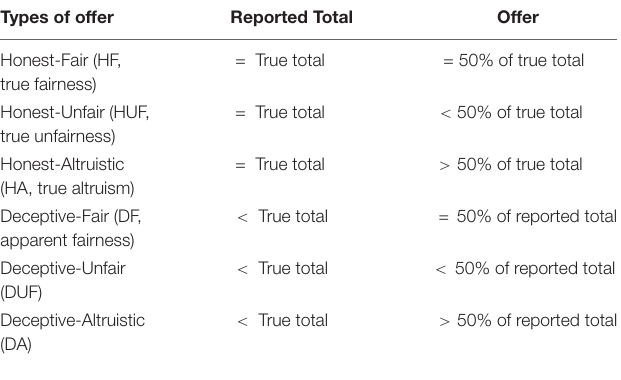
TABLE 1 | Definitions of six types of offers. Types of